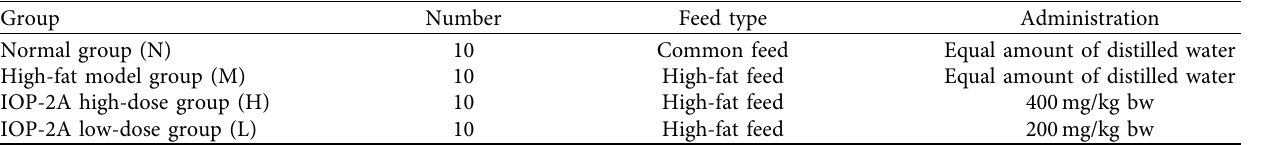
Table 1: Groups of mice.